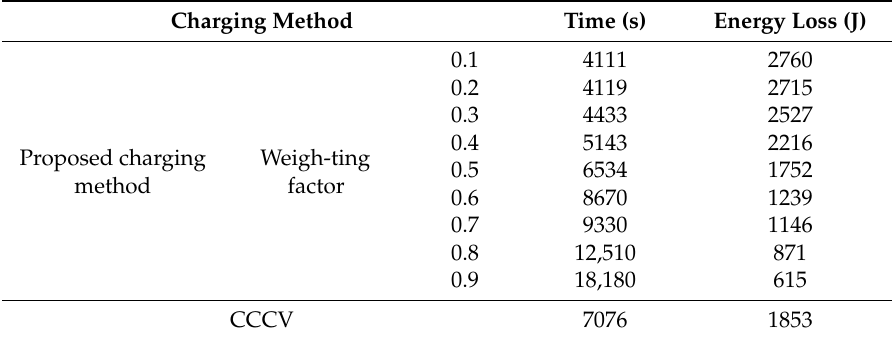
Table 3. Time and energy loss of the proposed charging method and CCCV charging method.